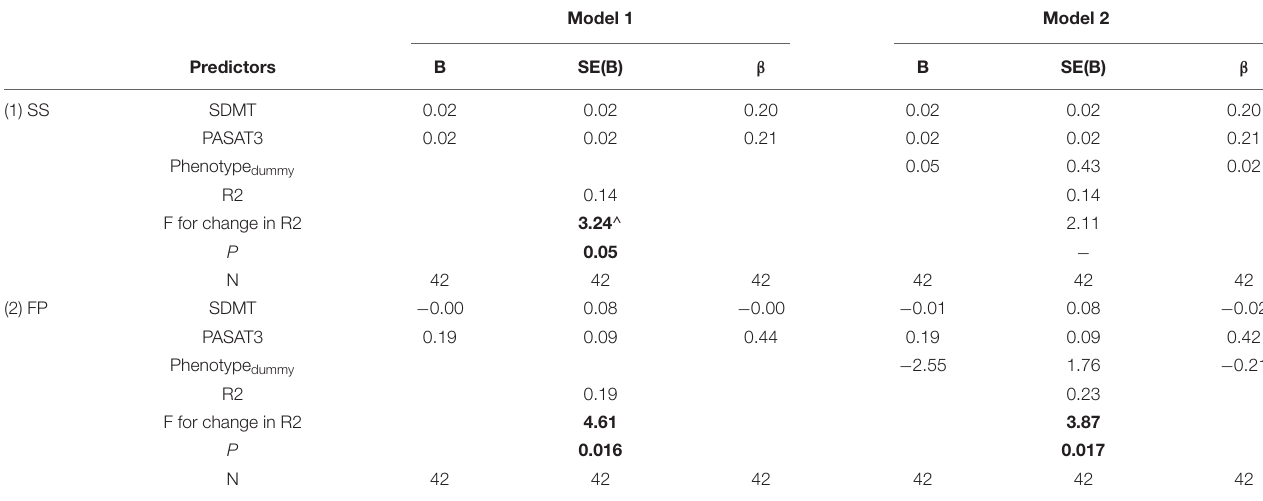
TABLE 4 | Regression analysis models of executive functions on ToM performance in all MS